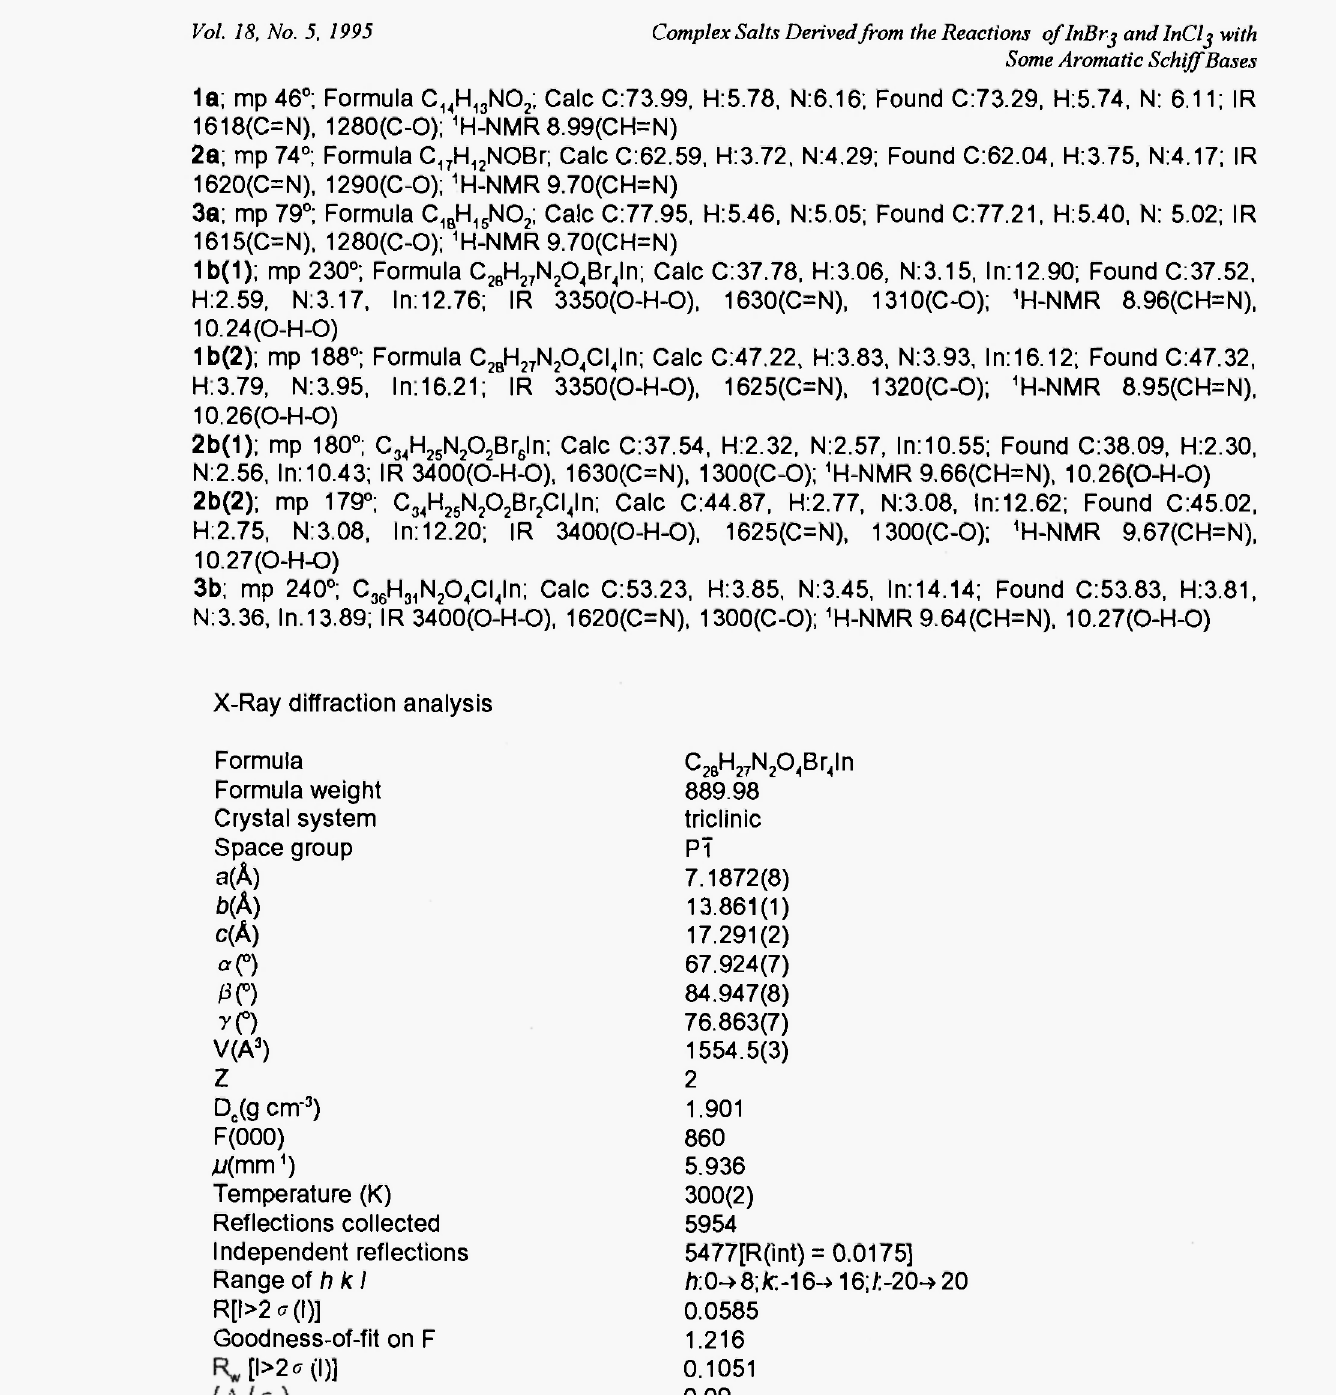
Table 1. Crystal data and details of structure refinement for compound 1b(1). List of themal parameters, structure factors, complete tables of bond lengths and angles are available from the author (G-Y.